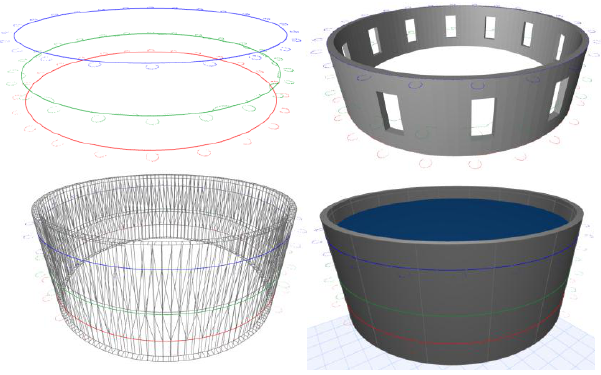
Figure 9: Irregular non-vertical walls containing